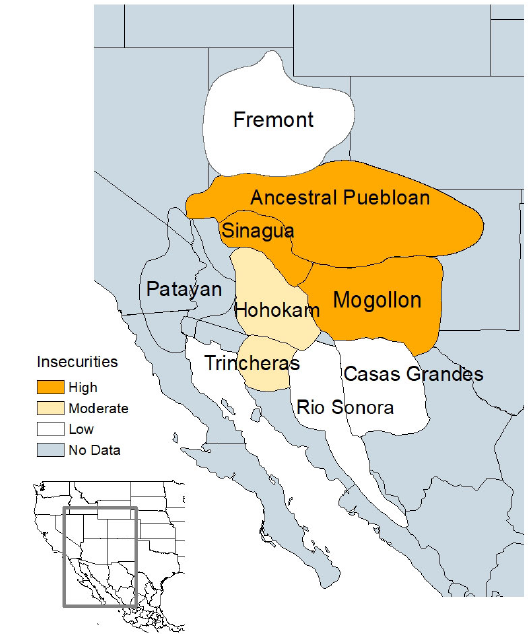
Fig. 5 . Environmental insecurity prior to depopulation (indicator: increasing relative climatic dryness).